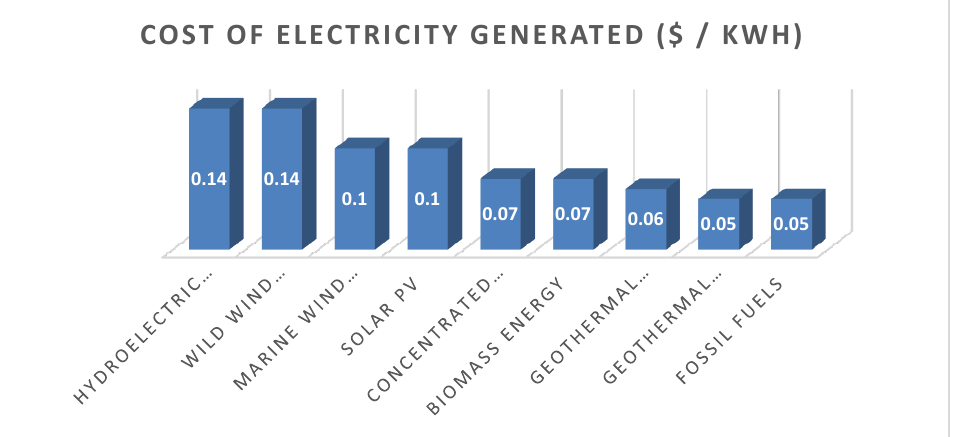
Figure 2. Average cost of electricity